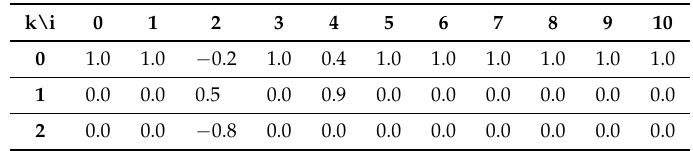
coefficients. ki